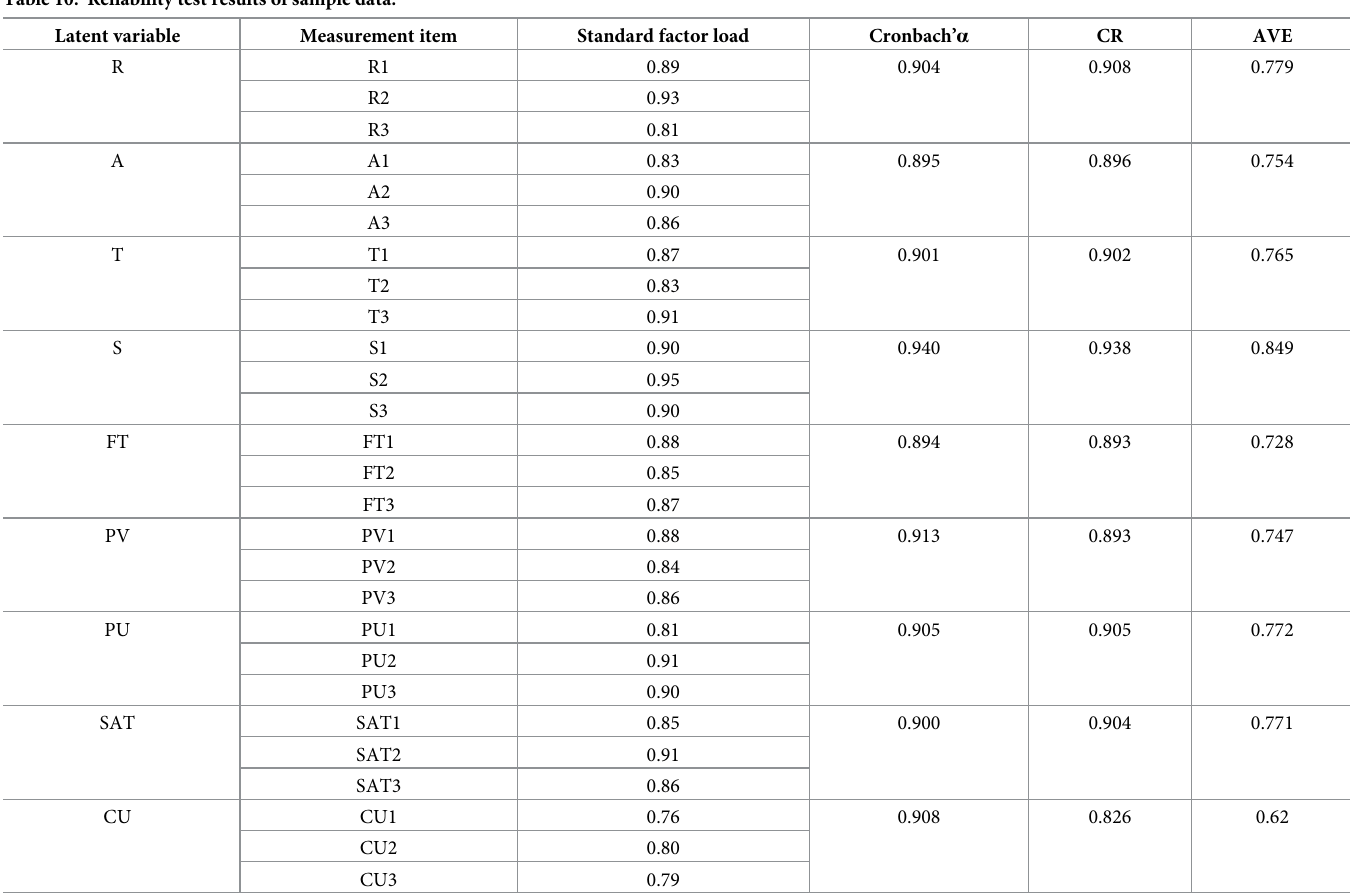
Table 10. Reliability test results of sample data.